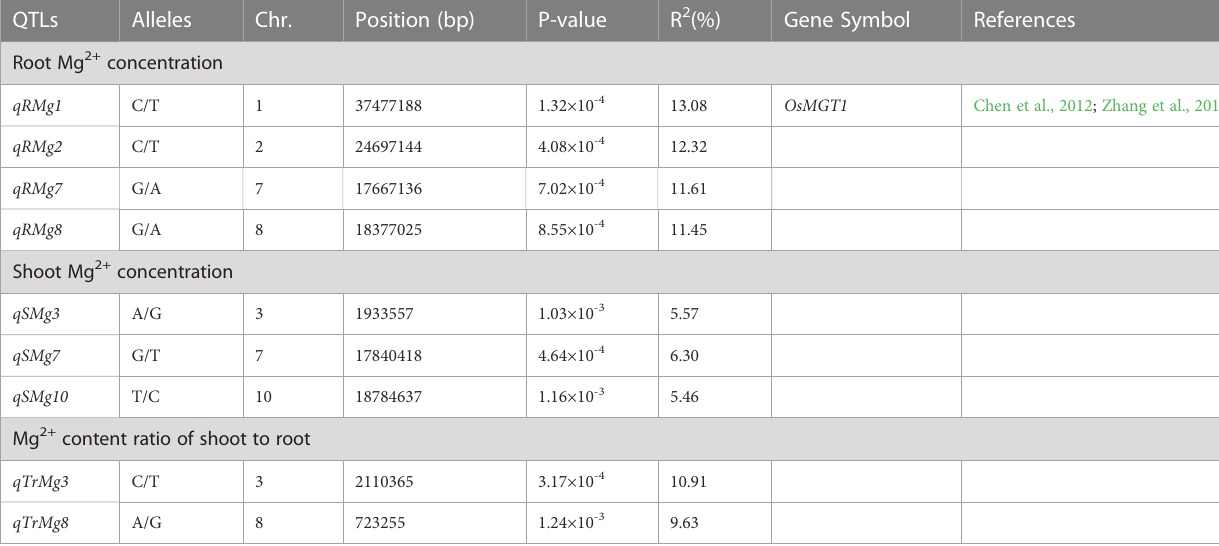
upstream of the ATG of LOC_Os03g04430 (Figure S3A). At the same time, we analyzed the gene sequence of LOC_Os03g04480 of the four parental lines, and found no natural variation (Figure S3B). The expression patterns of LOC_Os03g04360 , LOC_Os03g04430 and LOC_Os03g04480 in the four parental lines are shown in Figures 6B, S3C, D. Compared with the normal Mg 2+ supply, the expression of LOC_Os03g04360 was signi fi cantly induced by Mg 2+